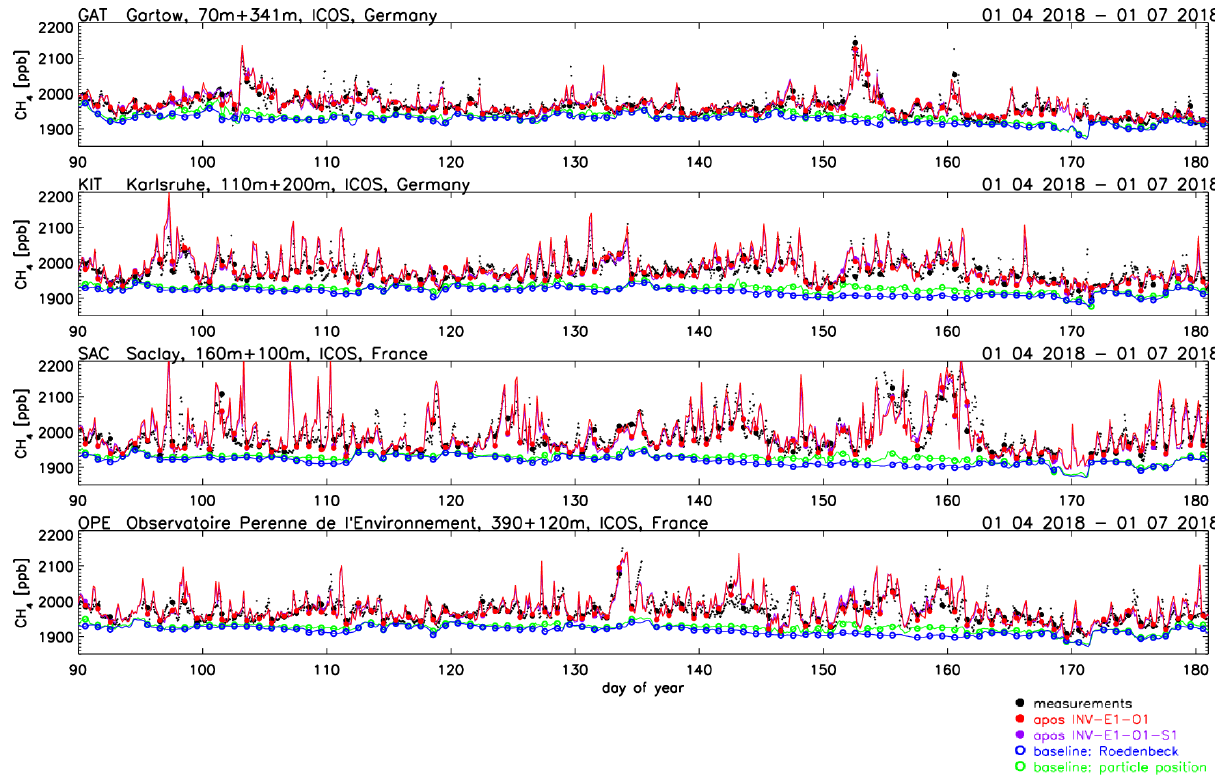
Figure 3. Time series of simulated and observed CH 4 mole fractions at stations GAT, KIT, SAC, and OPE for the 3-month period from 1 April until 1 July 2018. Blue curve shows the Rödenbeck baselines, green the particle position baselines, red the posterior CH 4 mole fractions for inversion INV-E1-O1 (using the Rödenbeck baselines), and violet the posterior CH 4 mole fractions for inversion INV-E1-O1-S1 (using the particle position baselines) (owing to the similarity of both posterior simulations, however, the results of INV-E1-O1-S1 are largely overlaid by those of INV-E1-O1). Small black dots: hourly averaged observations. Solid black circles: assimilated observations. Coloured symbols show the corresponding assimilated values (solid circles: assimilated posterior mole fractions; open circles: baseline values used for the